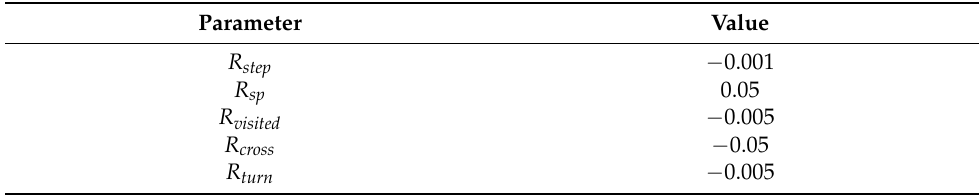
Table 4. Reward function